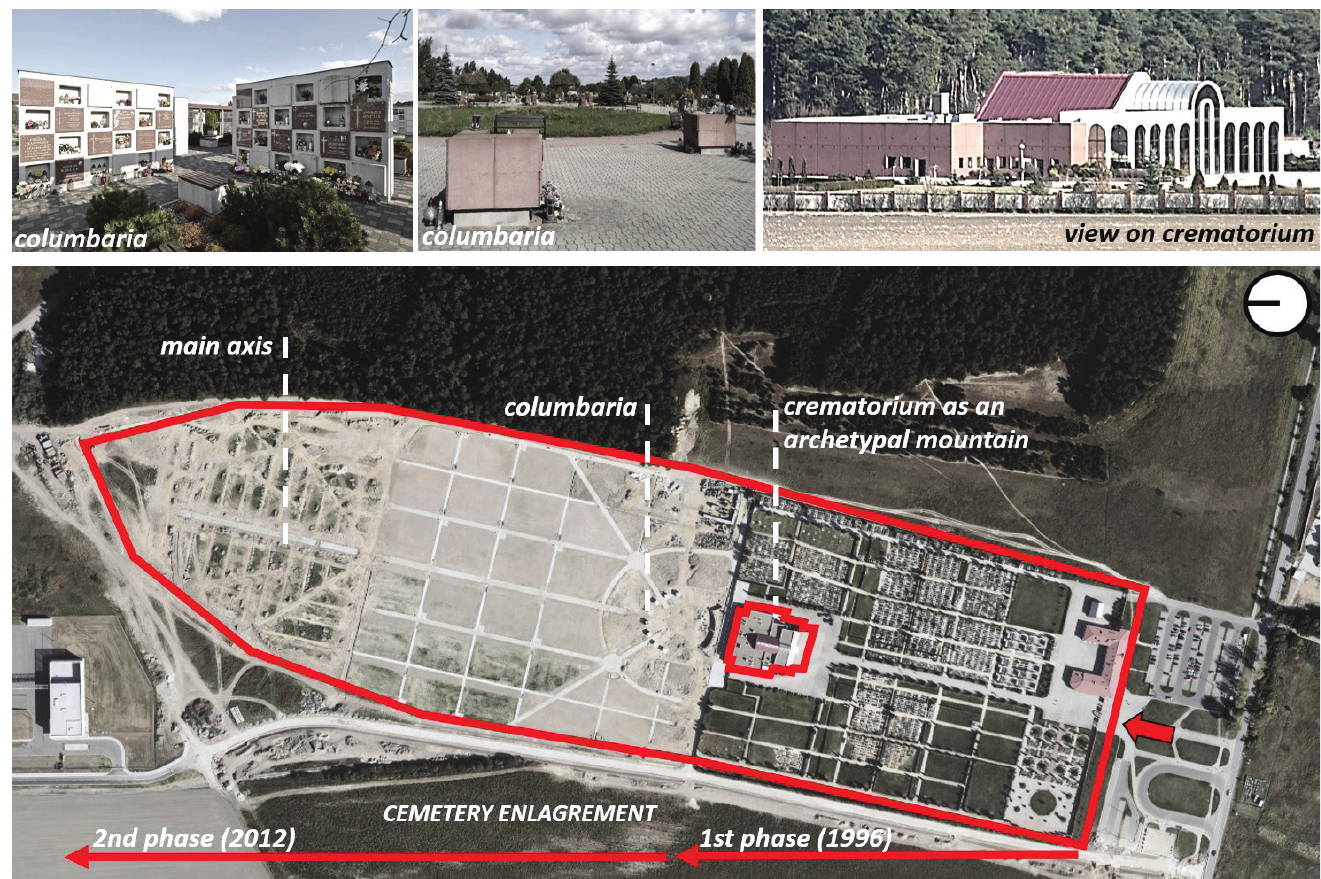
Figure 9. Location of crematorium in relation to the cemetery landscape, example of Antoninów. Own elaboration